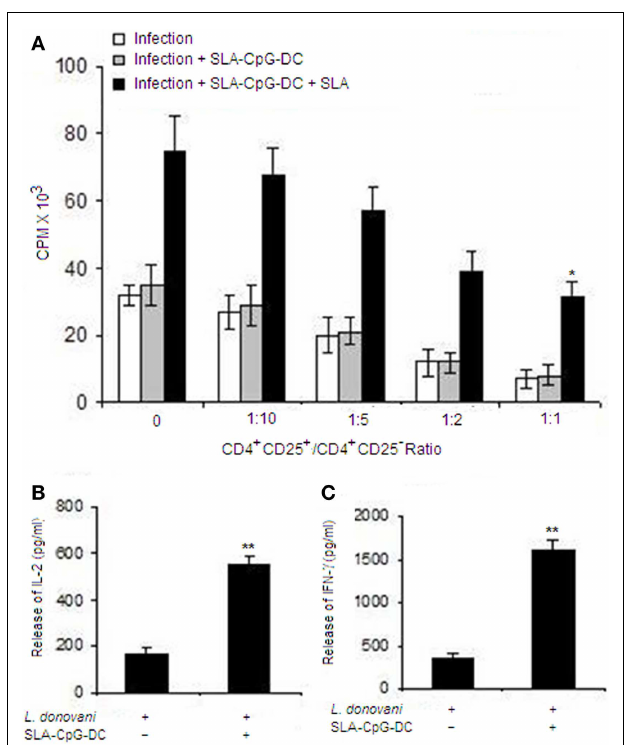
FIGURE 3 | Soluble leishmanial antigen–CpG–DCs vaccination reduces the suppressive properties of the CD4 + CD25 + Foxp3 + T cells in L. donovani -infected mice . (A) CD4 + CD25 + T regulatory cells and CD4 + CD25 − T cells were purified from spleen of differently treated mice (Materials and Methods) after 4weeks post-infection. CD4 + CD25 − T cells (5 × 10 5 ) andT-depleted, mitomycin C-treated syngeneic APCs (5 × 10 5 ) were stimulated with SLA (10 µ g/ml) and co-cultured in the presence of splenic CD4 + CD25 + T cells(1:1 ratio) from differently treated sets for 4days. Proliferation was determined by an 18h ( 3 H) thymidine incorporation assay. Data are presented as counts per minute (CPM) × 10 3 .The supernatants were collected at 24h for IL-2 (B) or at 72h for IFN- γ (C) following stimulation with SLA (10 µ g/ml) and levels of cytokines were determined by ELISA.The error bars represent mean ± SD of triplicate cultures.The experiments were performed three times, of which one set of representative data is shown (** P < 0.001 and * P <